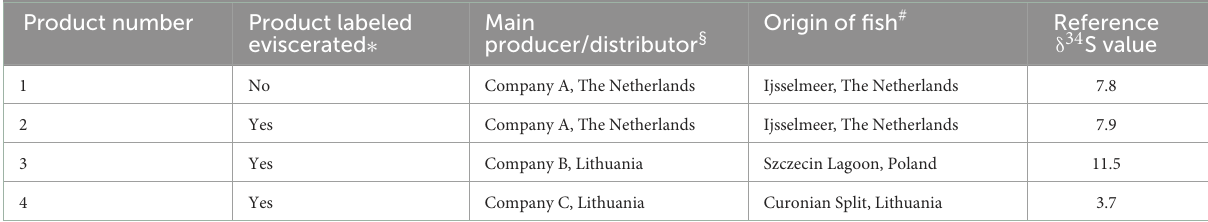
TABLE 2 Product description, producers/distributors, origin and δ 34 S of the four roach products that were distributed to outlets in Europe by the international wholesaler. Product